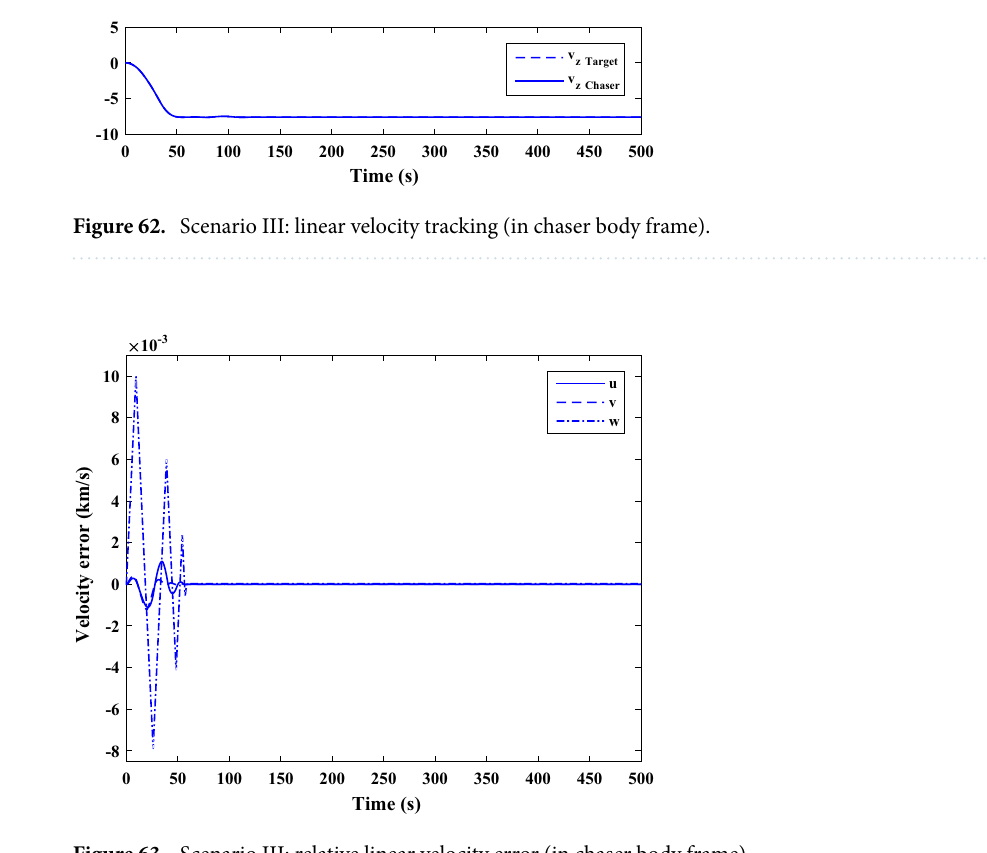
Figure 63. Scenario III: relative linear velocity error (in chaser body